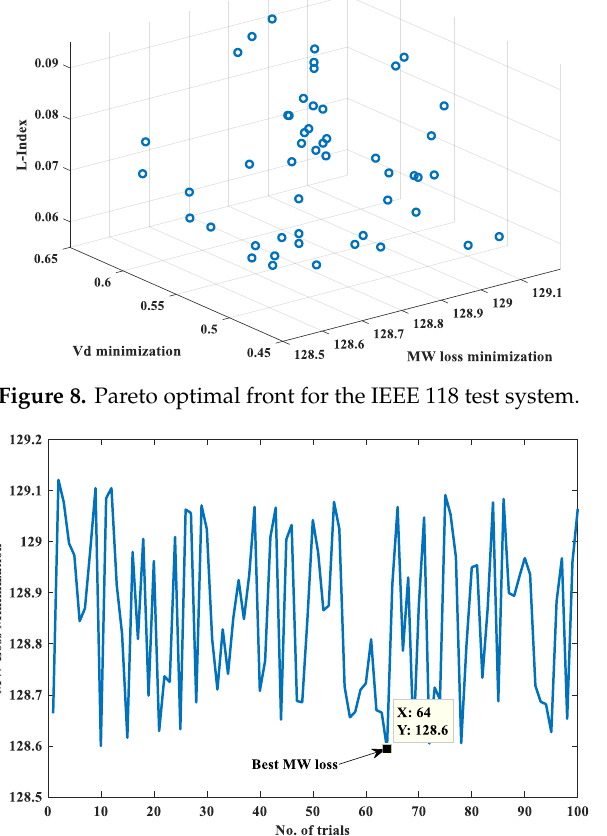
Figure 9. Megawatt (MW) loss minimization for the IEEE 118 test system over 100 trials. Table 6. Results of the single and multiobjective fitness functions of the APOPSO algorithm on the IEEE 118 test system.